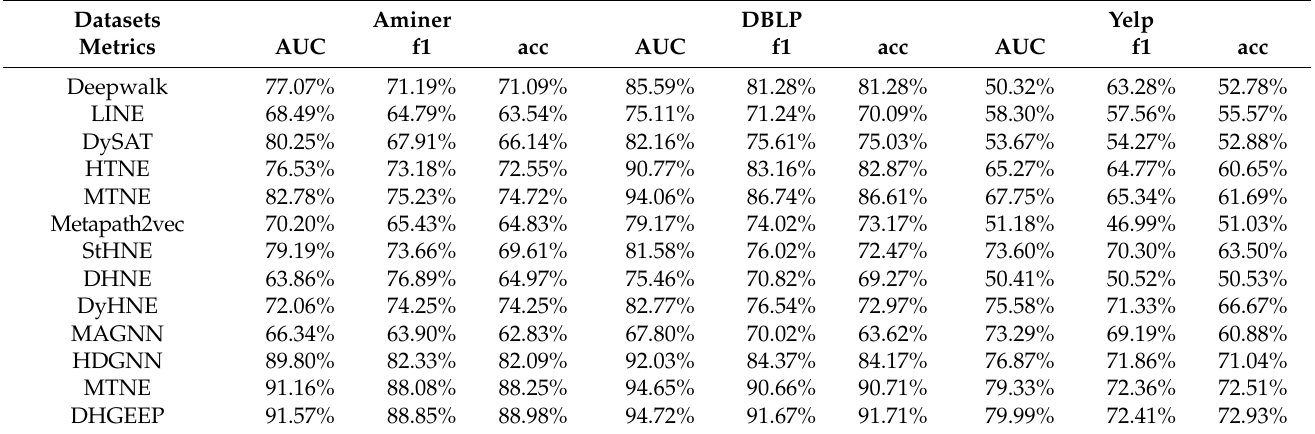
Table 2. Comparison of different algorithms in the link prediction